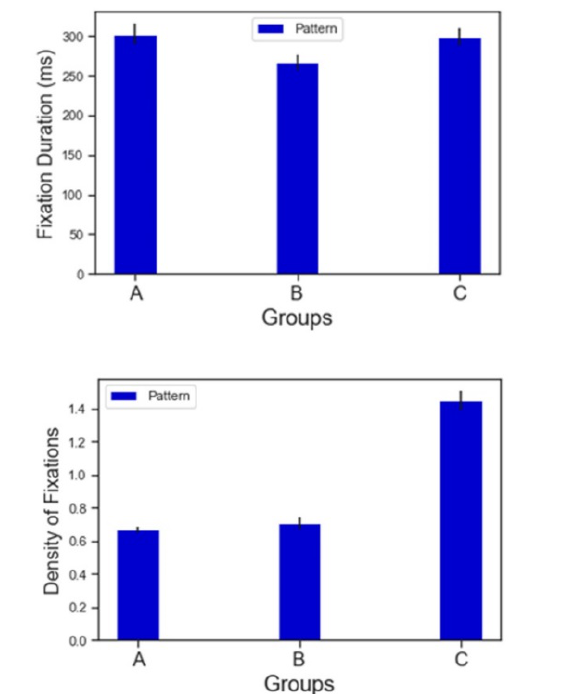
Figure 5.1, 5.2: Fixation duration (ms) and density of fixations across groups for AOI Pattern